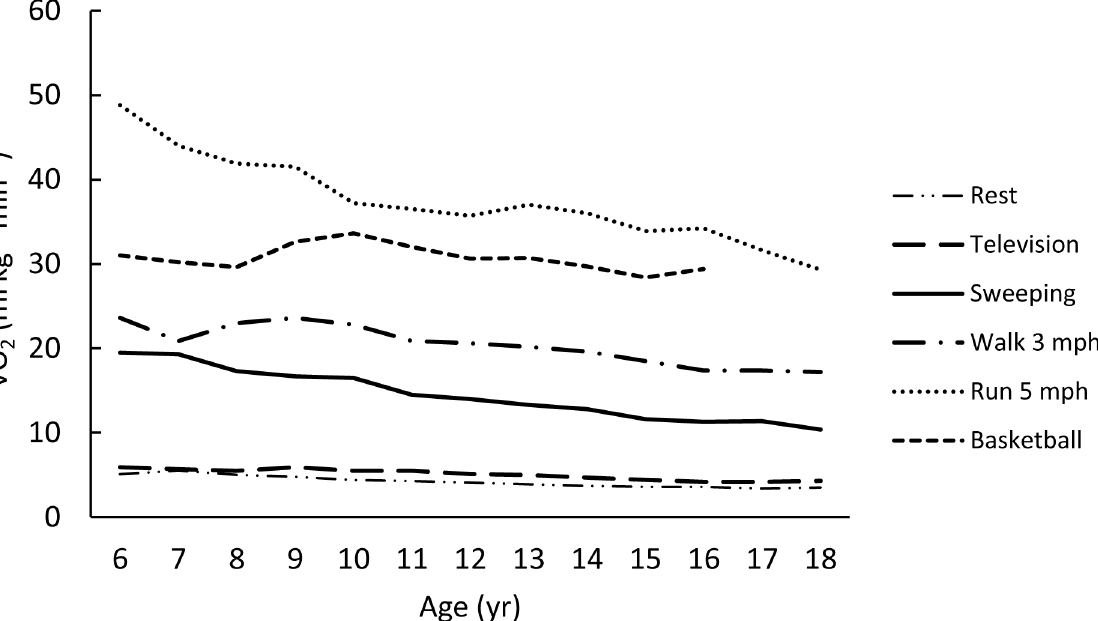
Fig 2. The relationships between age and VO 2KG (ml . kg -1. min -1 ) for six activities representing various intensities of physical